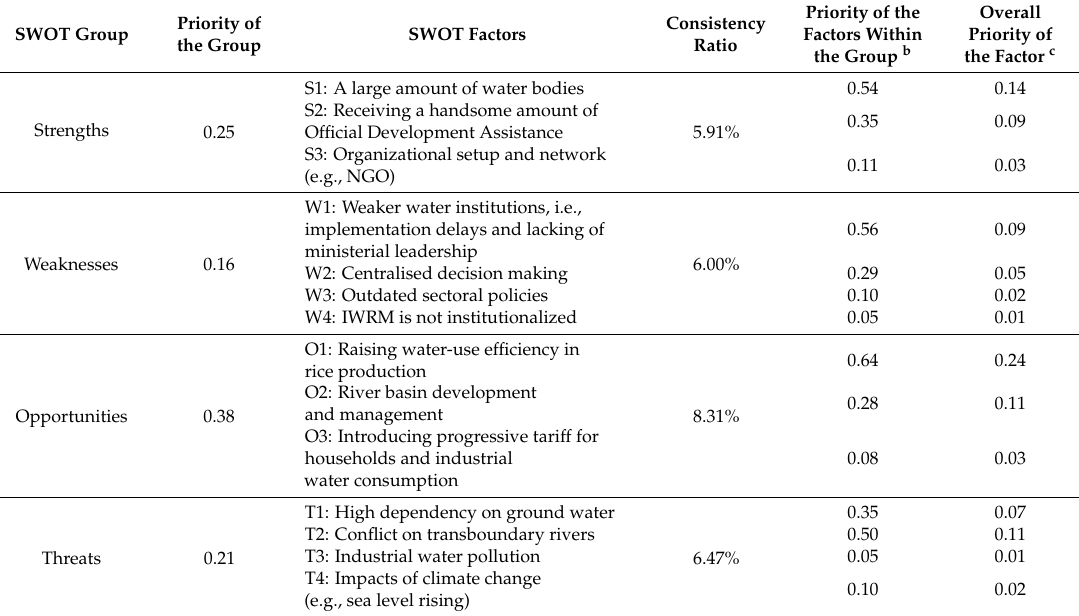
Table 3. Priority and consistency ratio a of the SWOT factors and groups, including the overall priority of the